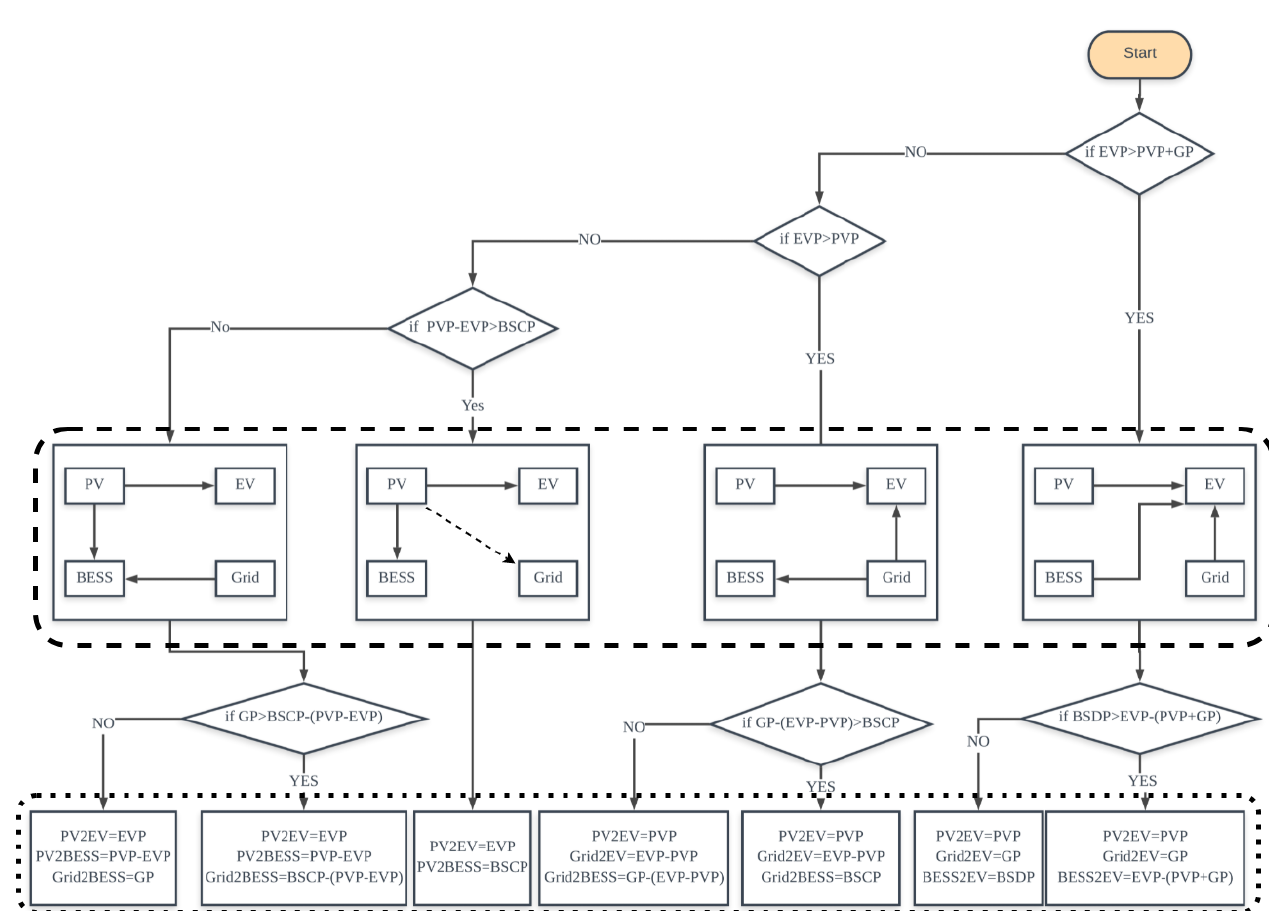
Figure 3. The energy flow in the